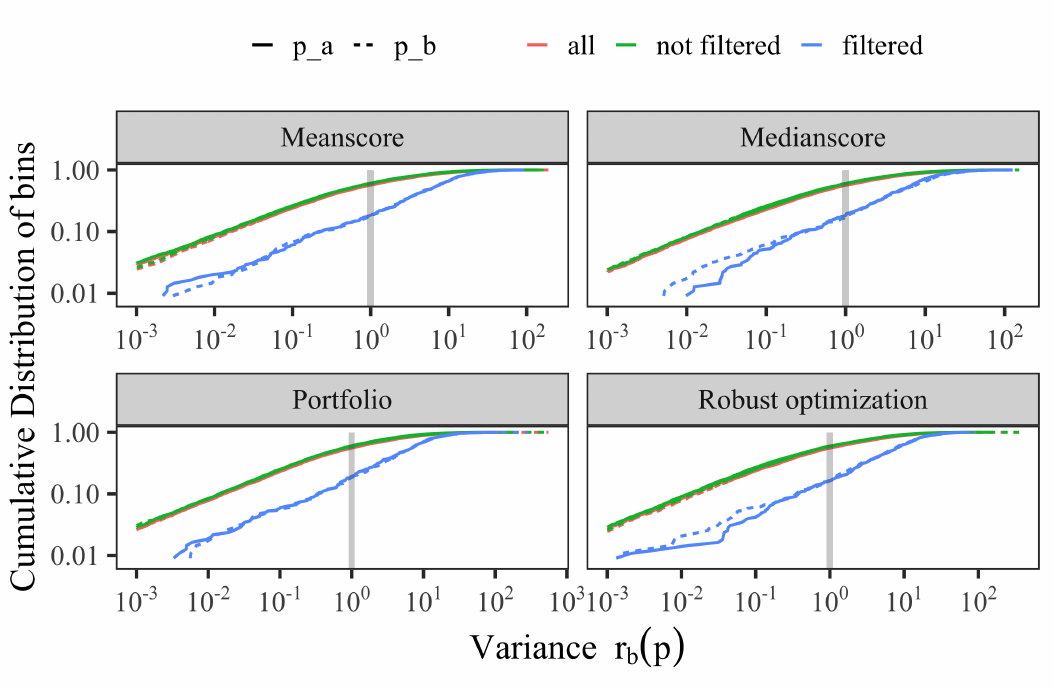
Figure 12: Cumulative distribution of bins for the A14 dataset at different bands of variance levels using different approaches. Results are shown using the parameters p ∗ obtained using all bins during optimization, and the parameters p ∗ a only the bin filtered bins are used during optimization.